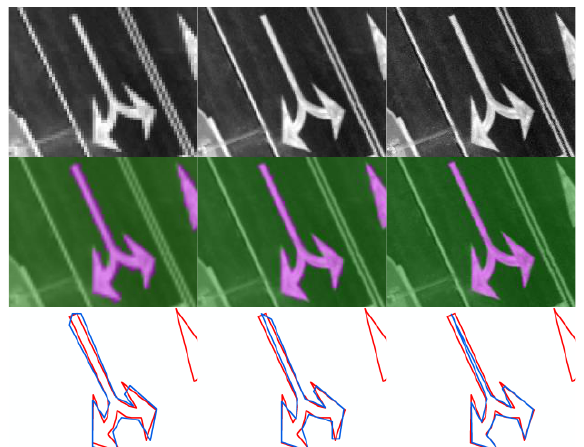
Figure 20. Sample arrow #3 – turn left or right (intensity-based).